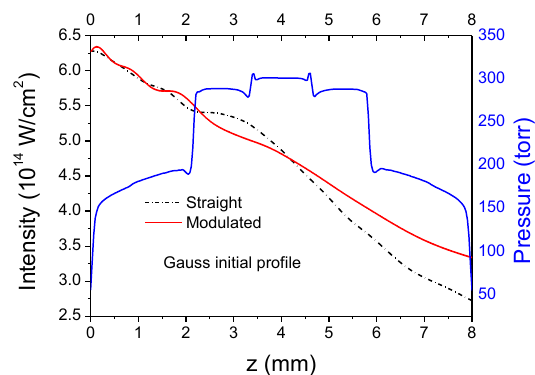
Fig. 4 On-axis peak intensity along the channel for the straight and a modulated HCW. The density profile of the He gas is also shown.